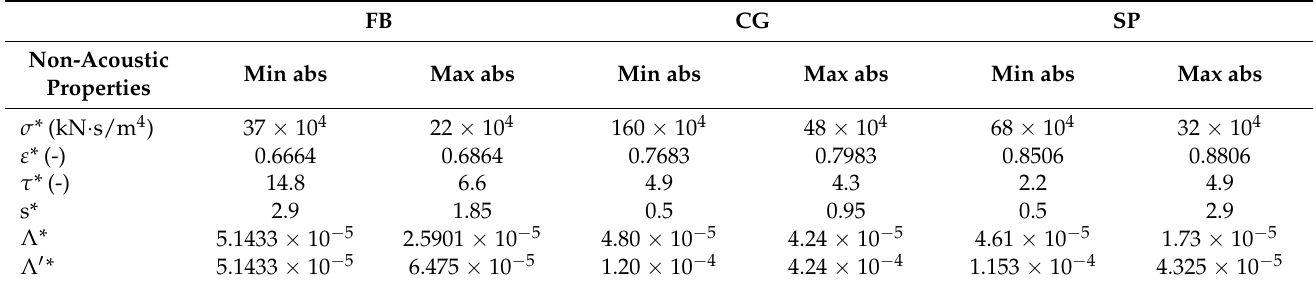
Table 5. Non-acoustic properties of experimental samples resulting from numerical estimation. FB CG